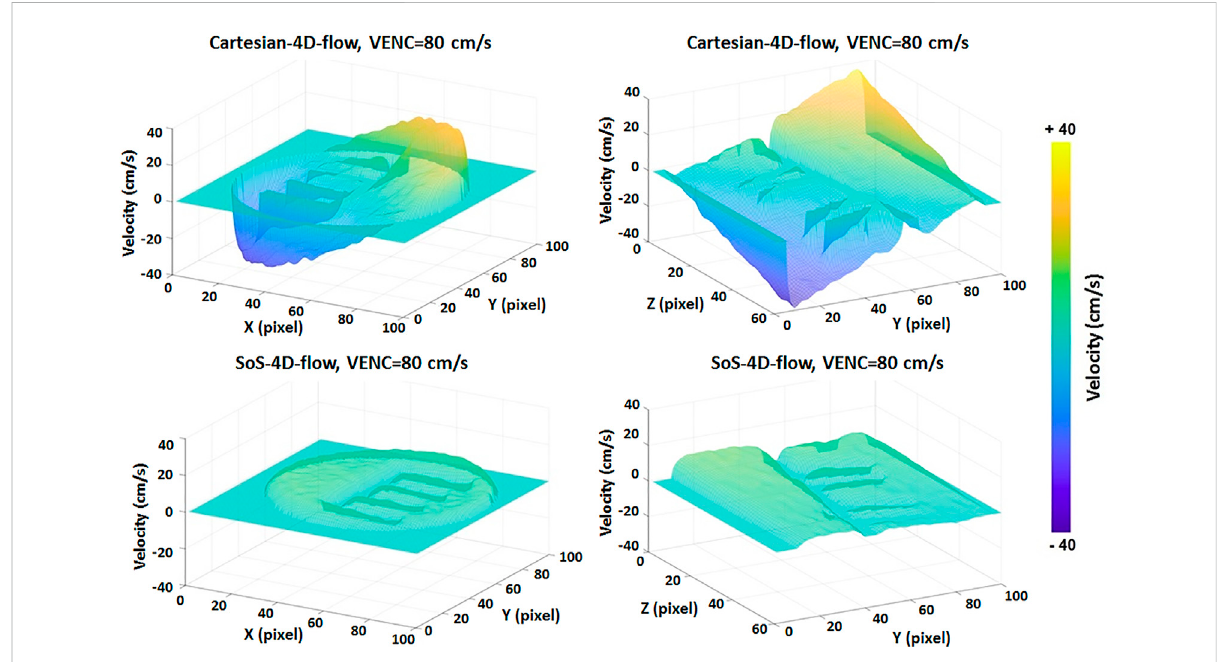
FIGURE 3 Representativeimageofthestaticphantominwhichthevelocityvaluesaresupposedtobeideallyequalto0 cm/sshowinghigherbackground velocity bias in Cartesian-4D- fl ow than in SoS-4D- fl ow. Each unit in pixel along the X,Y, and Z axes represents 300